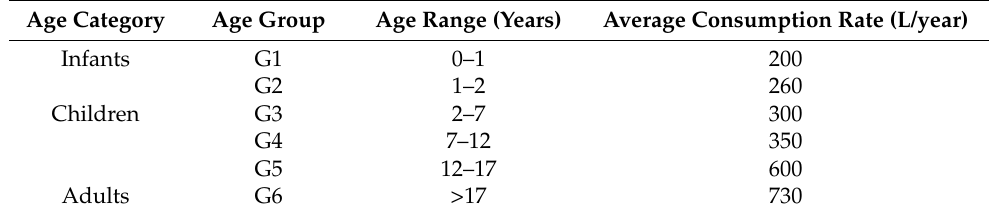
Table 3. The average consumption rate of water for each age category, as reported in reference [67].